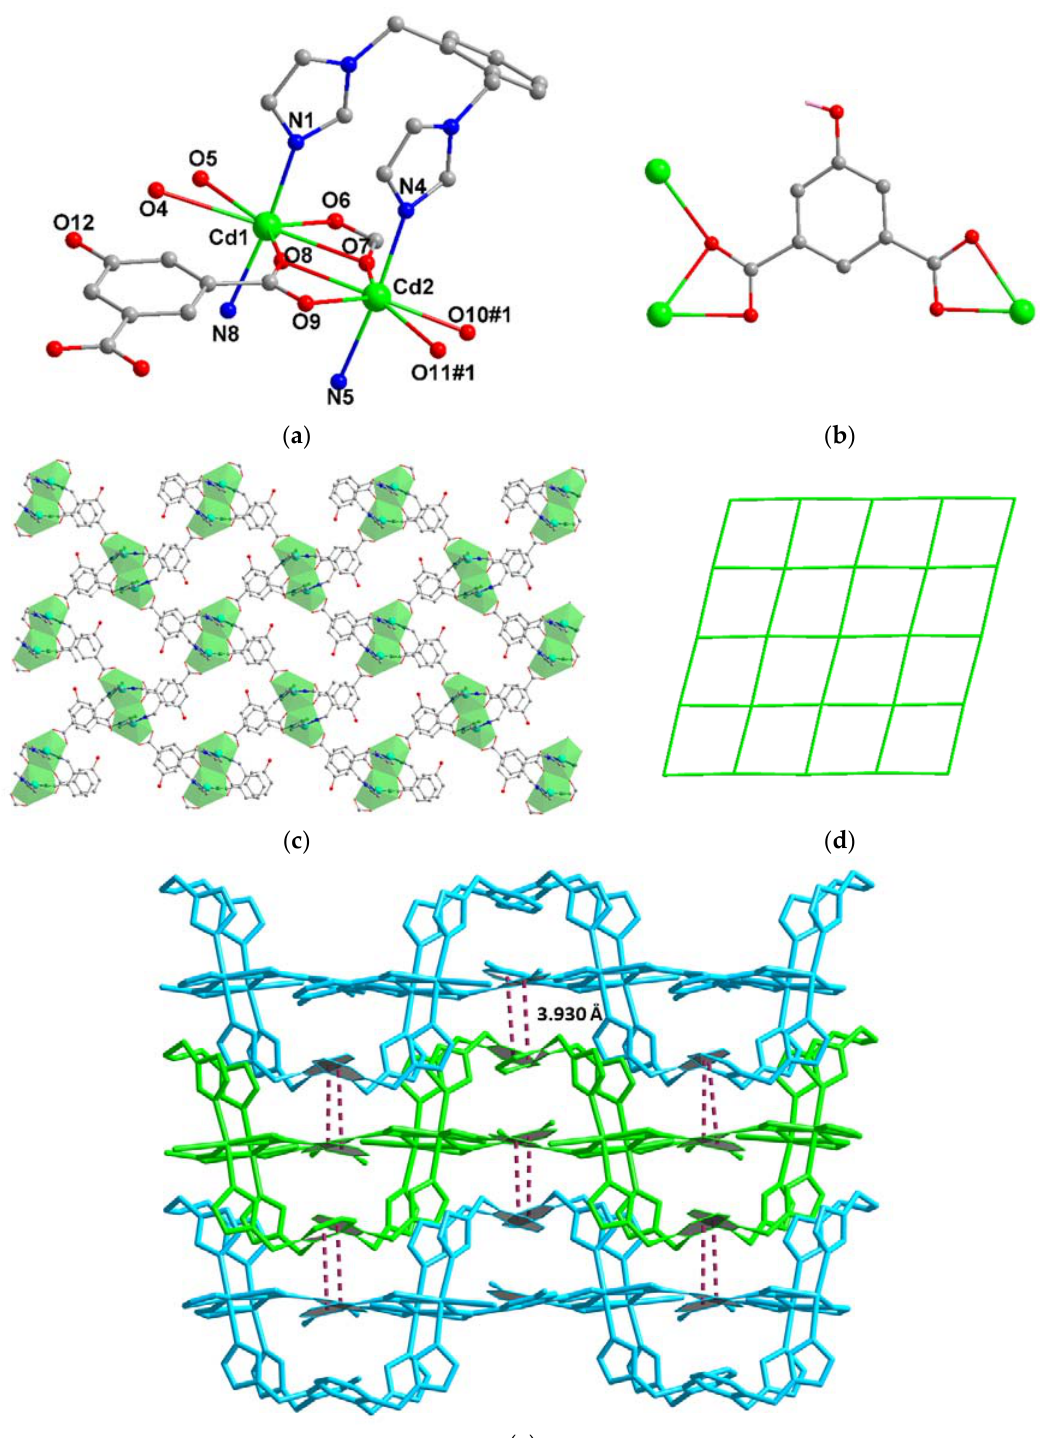
Figure 2. ( a ) The coordination environment of the Cd II ion in complex 2 (symmetry codes: #1 − 1 − X, ½ + Y, − 1/2 − Z); ( b ) The coordination mode of the 5 ‐ hipa ligand; ( c ) The 2D layered structure; ( d ) The sql topology of the complex 2 ; ( e ) The 3D supramolecular structure by π∙∙∙π interactions (green, Cd; blue, N; red, O; gray, C; pink, H).